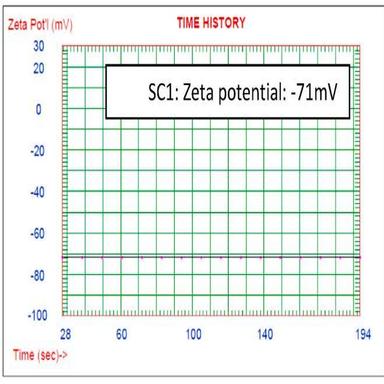
Zeta potential of SiO2@C nanocomposites.